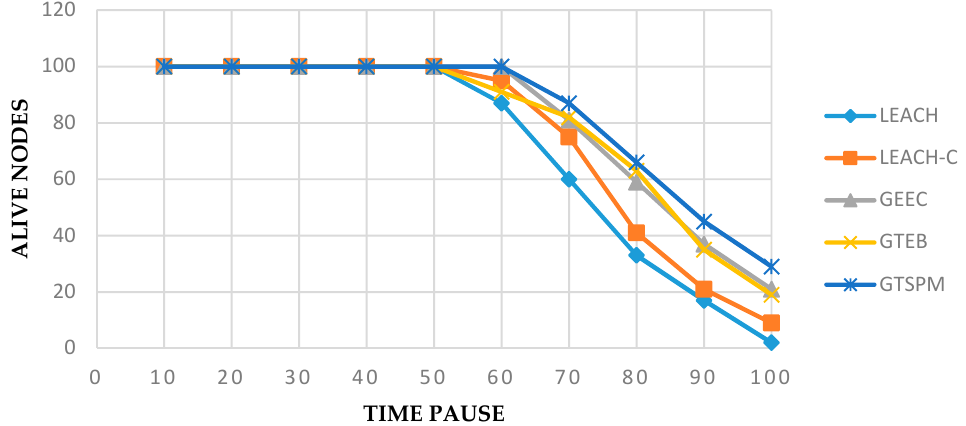
Figure 3. Number of alive nodes in different time pauses.